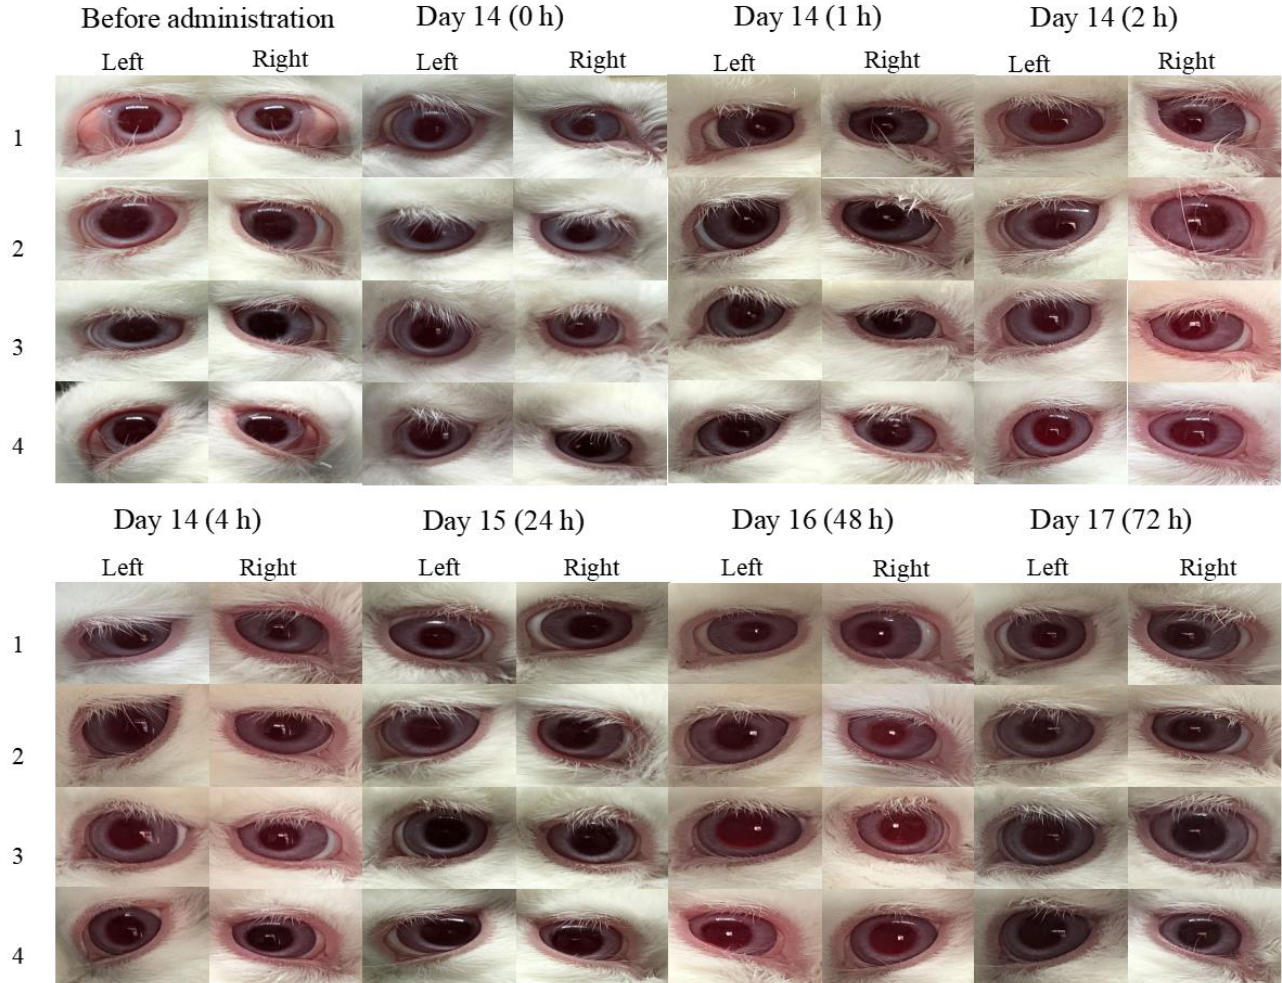
Figure 7. The obtained data of at 0, 1, 2, 4, 24, 48, and 72 h after the instillation of BRT-ISG and commercial product of BRT 14d continuously.